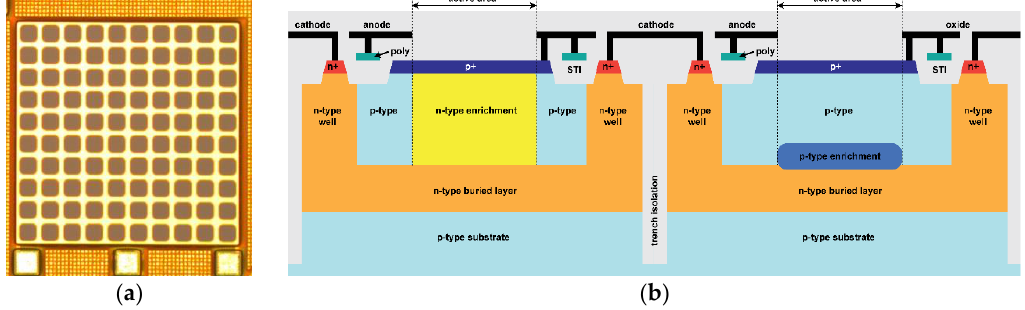
Figure 1. ( a ) Micrograph of a BCD SiPM with 10 × 10 microcells; ( b ) Cross-section of a BCD shallow SiPM microcell (left pixel) and of a deep SiPM microcell (right pixel).